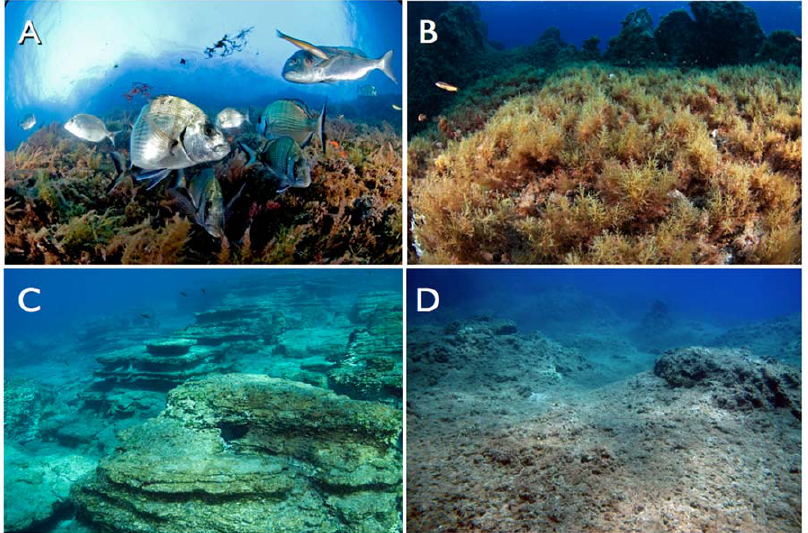
Figure 3. Examples of the major community states identified in this study: large fish biomass and non-canopy algae (‘predator- dominated’ ecosystems, i.e., the well-enforced marine reserves (A); ecosystems with lower fish biomass, but abundant algal canopies and suspension feeders (B); and ecosystems with lower fish biomass and extensive barrens (C), and areas covered by turf algae (D). (Photos: A,B: E Sala, C: Z Kizilkaya, D: A Verge´s).